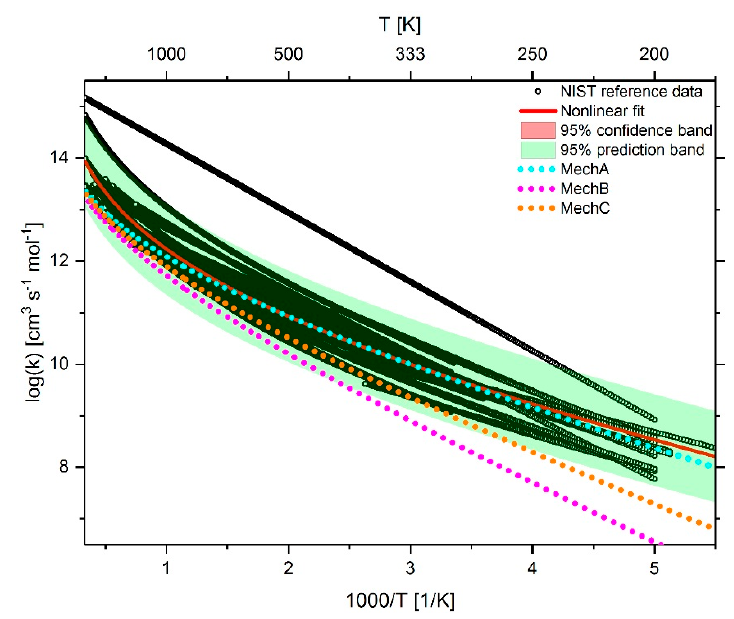
Figure 4. Comparison of the reaction rate coefficient of reaction 42 (CH 4 + OH ↔ H 2 O + CH 3 ) of MechA to MechC as well as the fitted rate coe ffi cient using reference data from the NIST (National Institute of Standards and Technology) database.